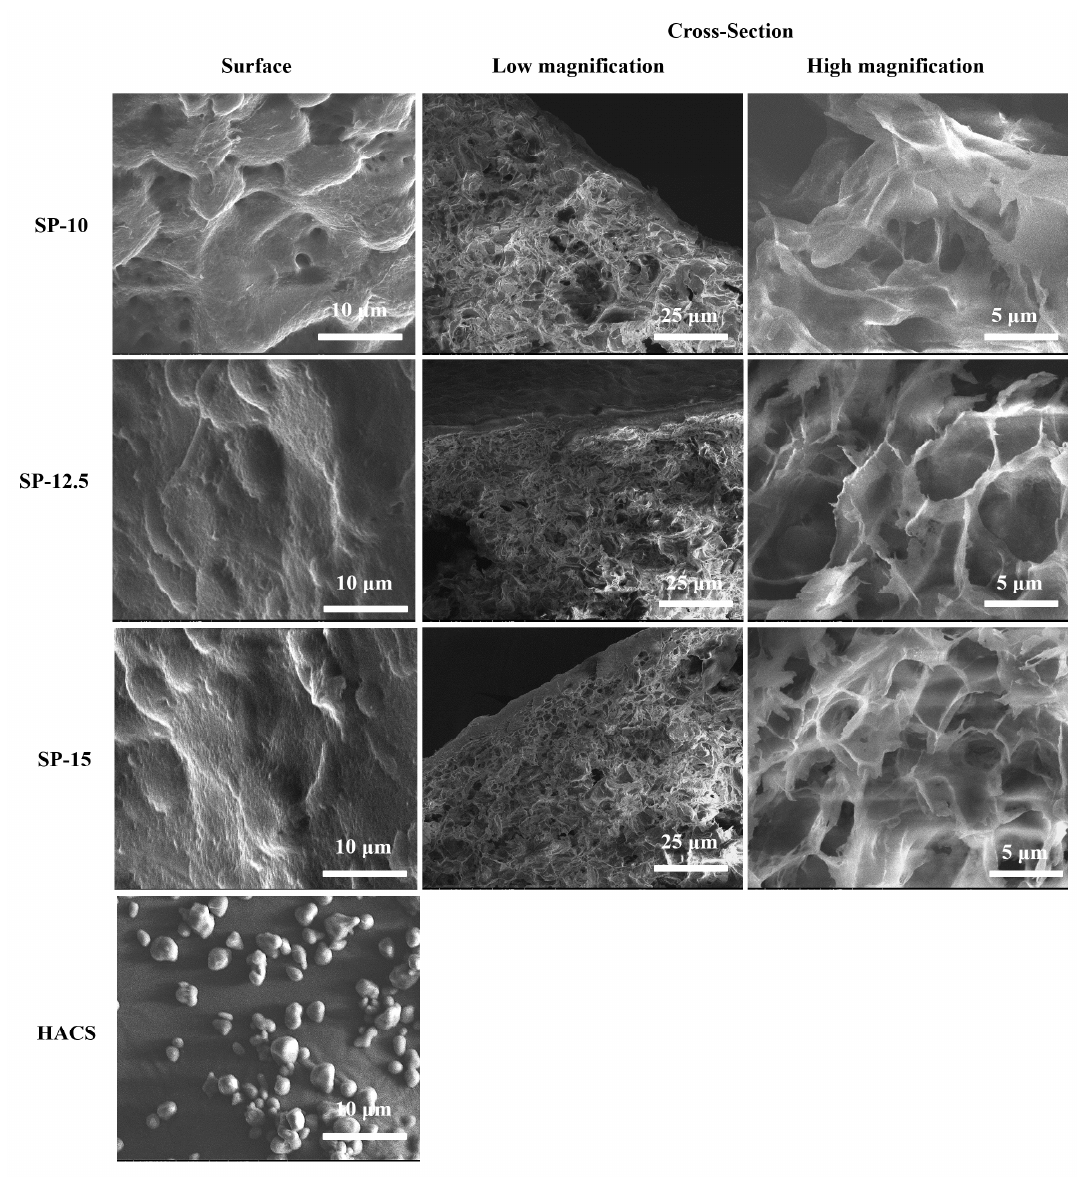
Figure 3. FE-SEM images taken from the surface and cross-section of the 3D-printed starch beads generated using starch concentrations of 10, 12.5, and 15% ( w / w ).